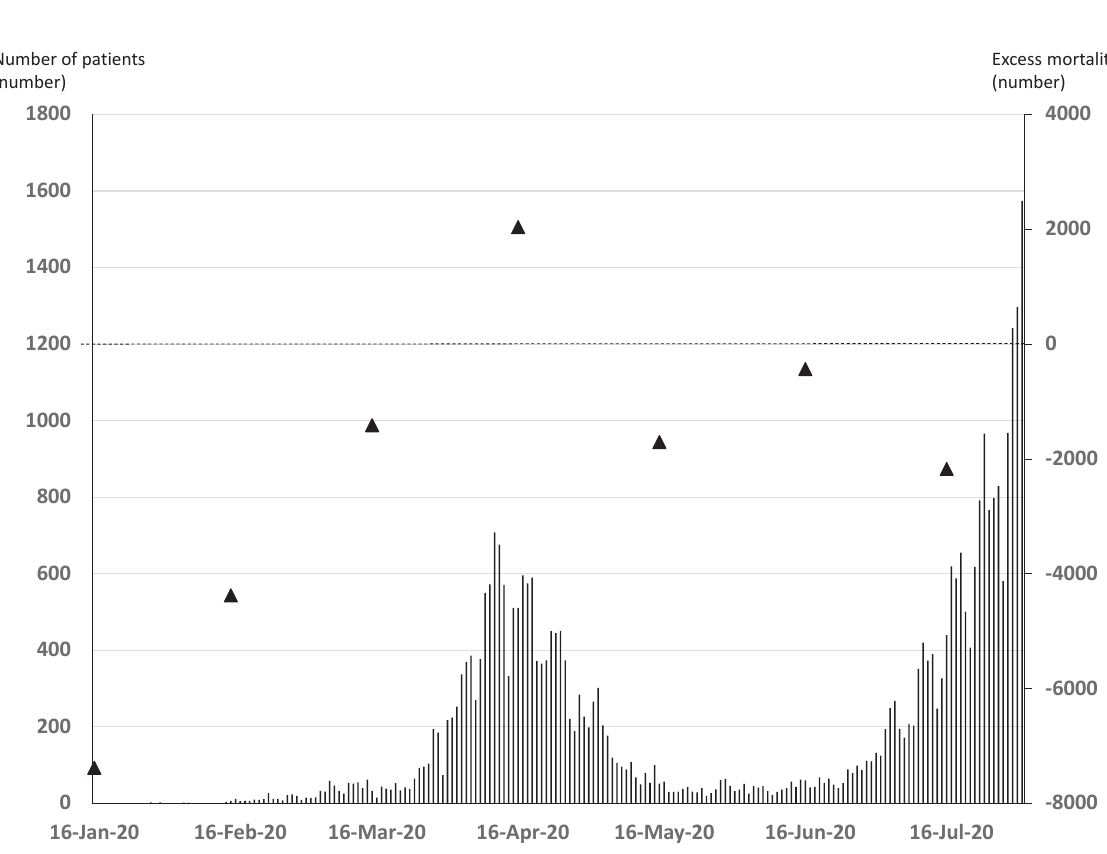
Figure 1. Daily number of patients with COVID-19 and monthly excess mortality in Japan ( ).